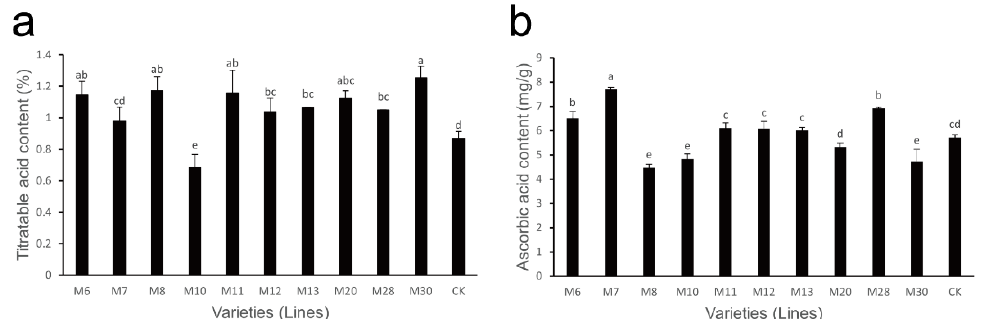
Figure 2. Changes in titratable acid content ( a ) and ascorbic acid ( b ) content in wild A. eriantha varieties (lines) at the ripening stage. The different letters in each figure indicate significant differences ( p < 0.05), and the same letters indicate no significant difference ( p > 0.05). The variations in AsA content in the soft ripe fruit of wild A. eriantha varieties (lines) are shown in Figure 2b. The content of AsA ranged from 4.47 mg/g (M8) to 7.70 mg/g (M7), with a mean value of 5.85 mg/g and a coefficient of variation of 16.75% (Table 2). Compared with the control, the AsA content in M8, M10 and M30 was relatively lower, while its content in M6, M7 and M28 was higher. The AsA content in the other samples was similar to that of the control. 3.4. Changes in Sugar Components in Wild A. eriantha of Different Varieties (Lines) The changes in sugar components for wild A.eriantha of different varieties (lines) at the soft ripe stage are shown in Figure 3a. The content of fructose in the A. eriantha samples ranged from 12.12 mg/g (M6) to 116.81 mg/g (M28), with an average content of 52.02 mg/g and a coefficient of variation of 56.94% (Table 2). The fructose content in M6, M8 and M30 was relatively low, while the fructose content in the M10 and M28 varieties was relatively high. The variation range in glucose content was 8.70 mg/g (M6) to 63.53 mg/g (M10), with an average of 37.69 mg/g and a coefficient of variation of 38.95% (Table 2). The glucose content in M6, M28 and M30 was relatively low; the glucose content in M10 was the high- est; and the glucose content of the remaining samples was similar. The sucrose content in the A. eriantha samples varied from 13.13 mg/g (M10) to 71.53 mg/g (M8), with an average value of 35.27 mg/g and a coefficient of variation of 54.27% (Table 2). The sucrose content in the M10, M11 and M28 varieties was relatively low, while that in M7 and M8 was rela- tively high. The two samples with the highest sum of the three main soluble sugar con- tents (fructose, glucose and sucrose) were M28 and M10, which were 160.23 mg/g and 159.58 mg/g, respectively, while M6 and M30 had the lowest total soluble sugar contents of 42.53 mg/g and 80.59 mg/g, respectively (Figure 3a). The soluble sugar content levels in the other samples were relatively close, all exceeding l10 mg/g (Figure 3a).